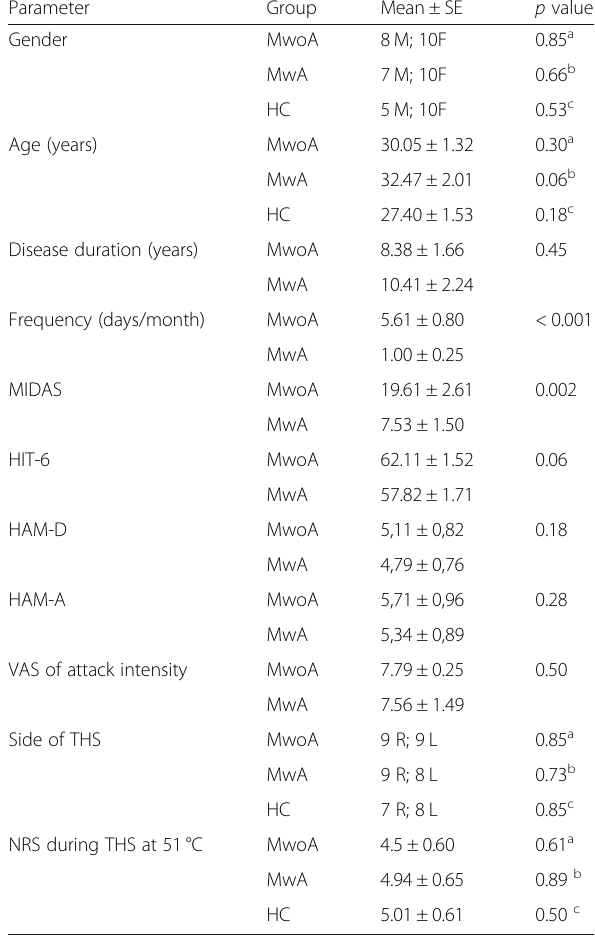
with MwA and HC